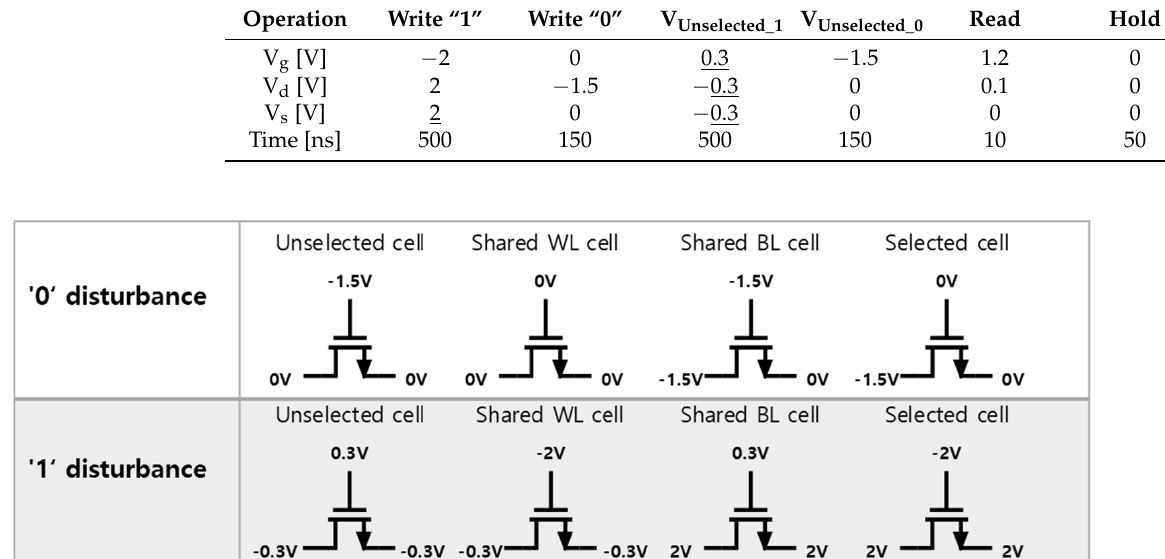
Figure 10. Voltage applied at each cell location depending on the type of disturbance in second simulation.